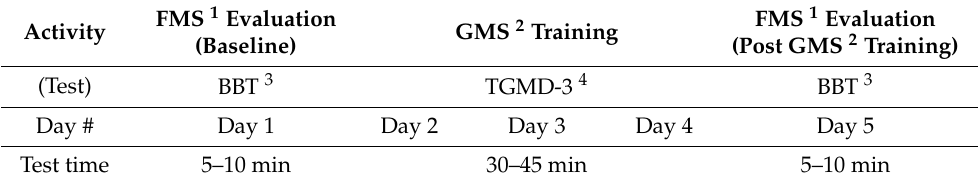
Table 3. Timeline of the study.